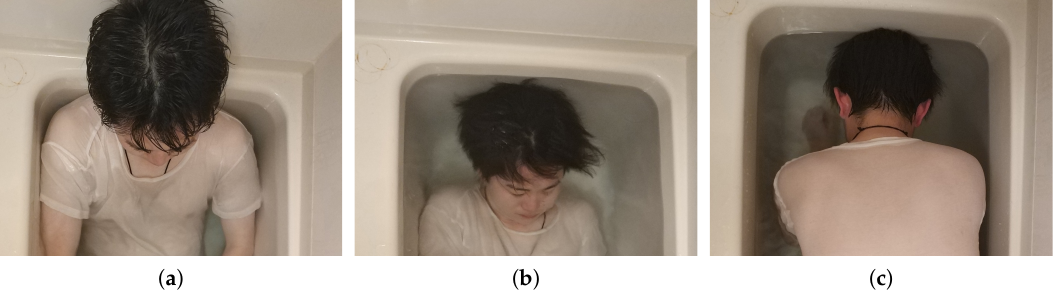
Figure 9. Simulated three dangerous situations: ( a ) steady lying position, ( b ) the whole body sinks below the water surface, and ( c ) the face sinks below the water